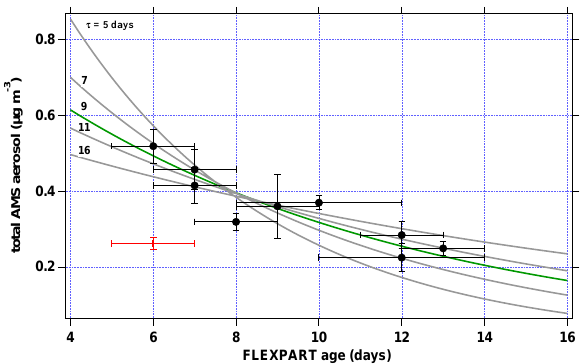
Fig. 14. Lifetime estimation of accumulation mode non-refractory aerosol originating from North American fossil fuel combustion and biomass burning: the horizontal bars represent the standard devi- ation of the average FLEXPART plume age, the vertical bars the standard deviation within the AMS data of the specific plume. The green line denotes an exponential fit with a τ between 7 and 11 days. The grey lines represent fits to the data with lifetimes as found in other Arctic aerosol studies (Paris et al., 2009; Koch and Hansen, 2005; Farina et al., 2010). The red cross illustrates an